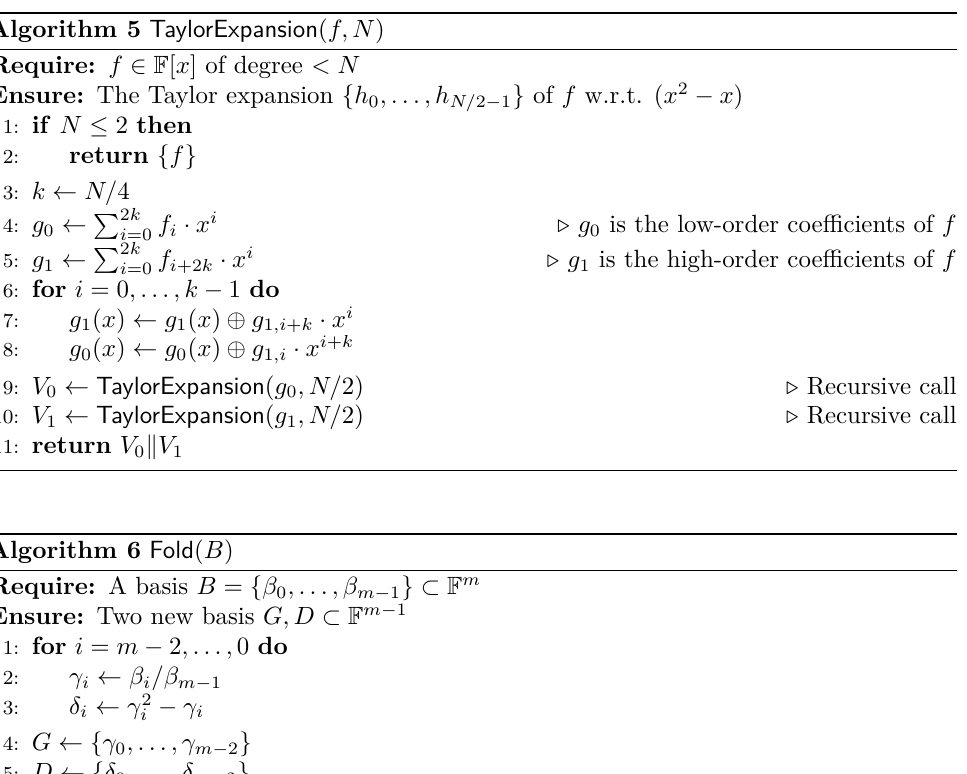
Algorithm 5 TaylorExpansion ( f, N )